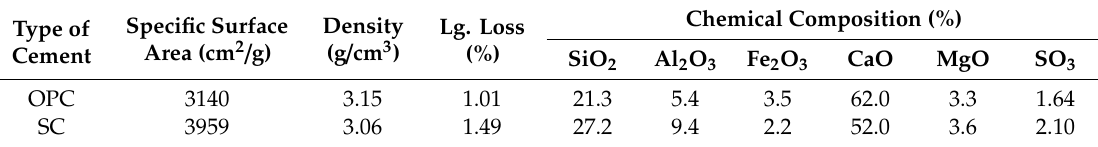
Table 3. Mix proportion used for the manufacturing of liquefied red mud.